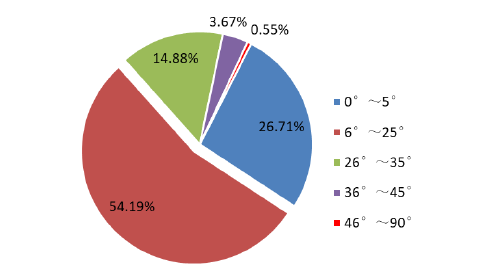
Figure 2. Percentage of slope in Lijiang River